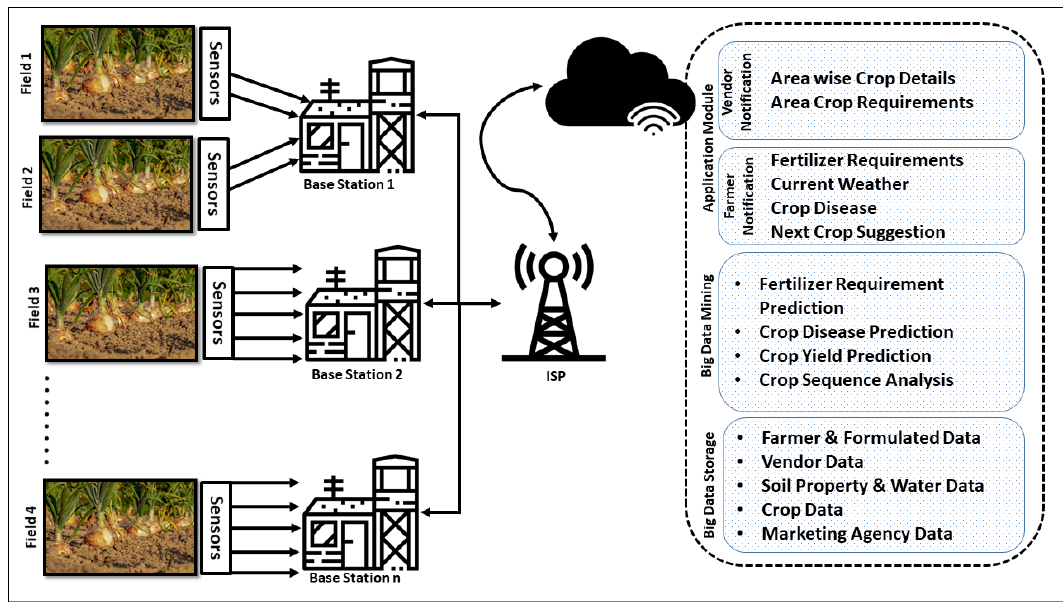
Figure 1. The architecture of cloud-based Internet of Agriculture Things (Adapted from